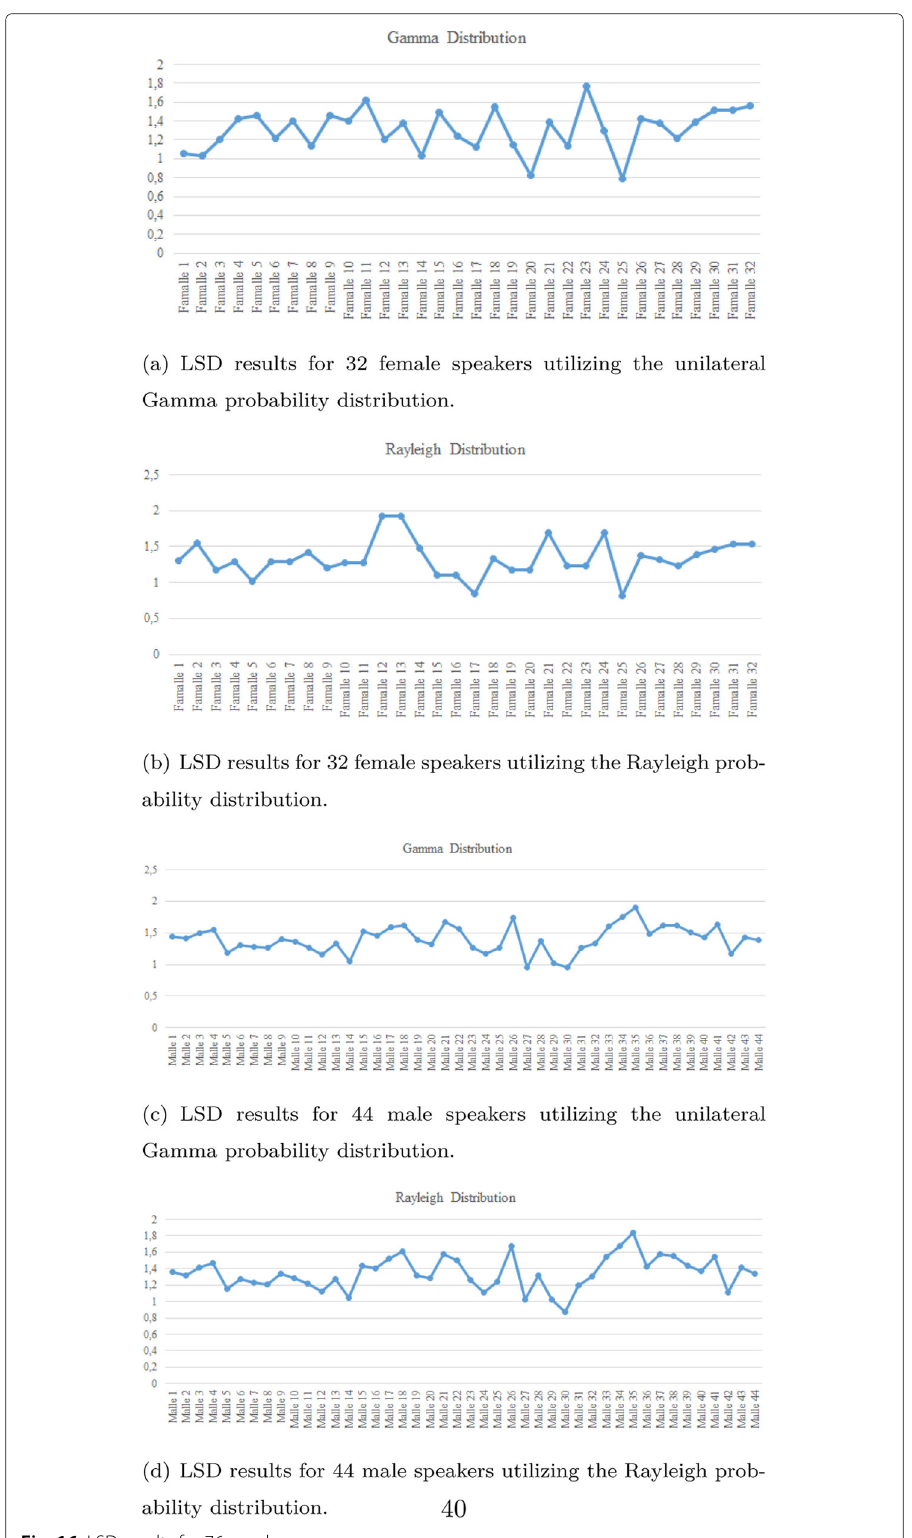
Fig. 16 LSD results for 76